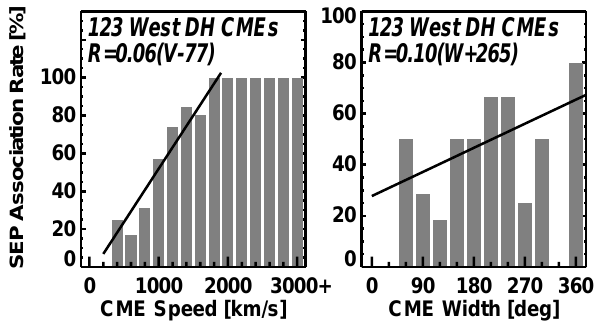
Fig. 11. Same as Fig. 10, but the SEP association rate for the west- ern hemispheric CMEs accompanied by DH type II bursts.